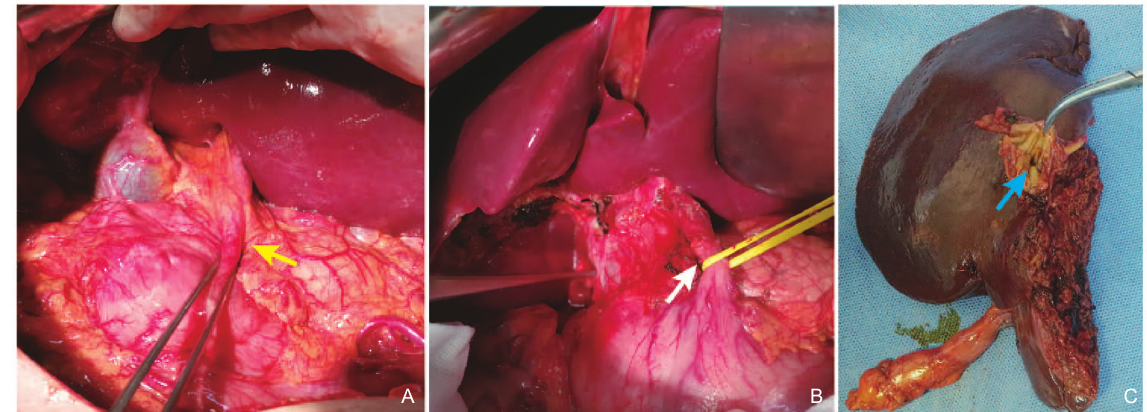
Figure 4 Findings during surgery. (A) The fistula (yellow arrow) was detected; (B) After the gallbladder was dissected and surrounding tissues were separated, the fistula between the lesser curvature of the stomach to the left intrahepatic bile duct (white arrow) was observed; (C) The opening of the fistula (blue arrow) was observed in the dissected left hepatic